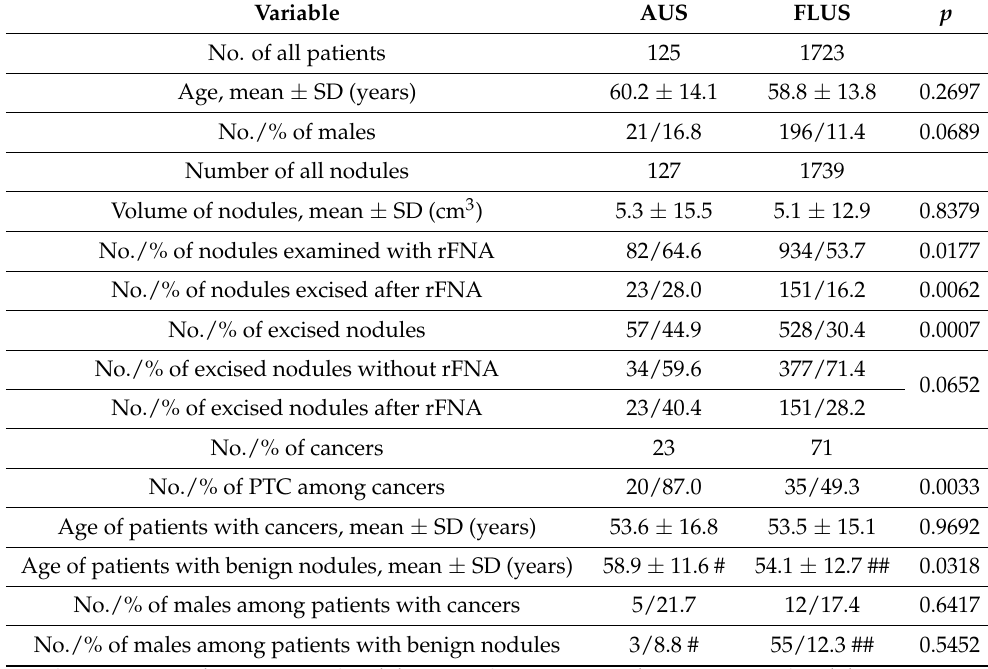
Table 1. Demographic data of the patients with nodules with cytologic/nuclear atypia (AUS) and nodules with architectural atypia (FLUS), including data on nodules subjected to repeat FNA (rFNA) or surgical treatment. Variable AUS FLUS p No. of all patients 125 1723 Age, mean ± SD